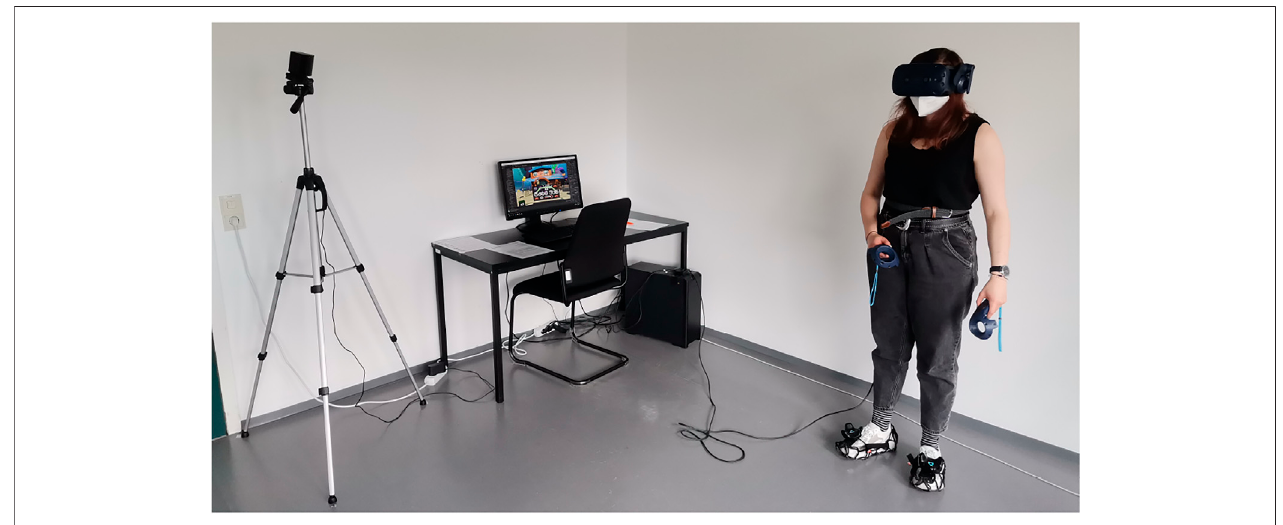
FIGURE 8 | Overview of the experimental